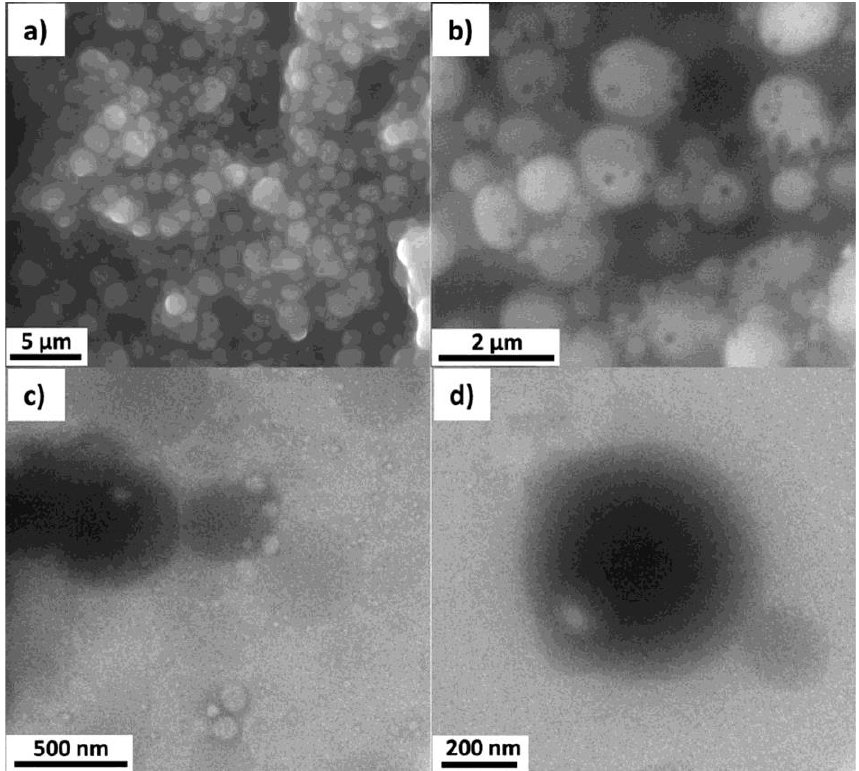
Figure 7. Morphology of the latex phase obtained with the siloxane oligomer and f = 0.8 conditions (sample EG7) observed by SEM ( a , b ) and TEM ( c , d ).